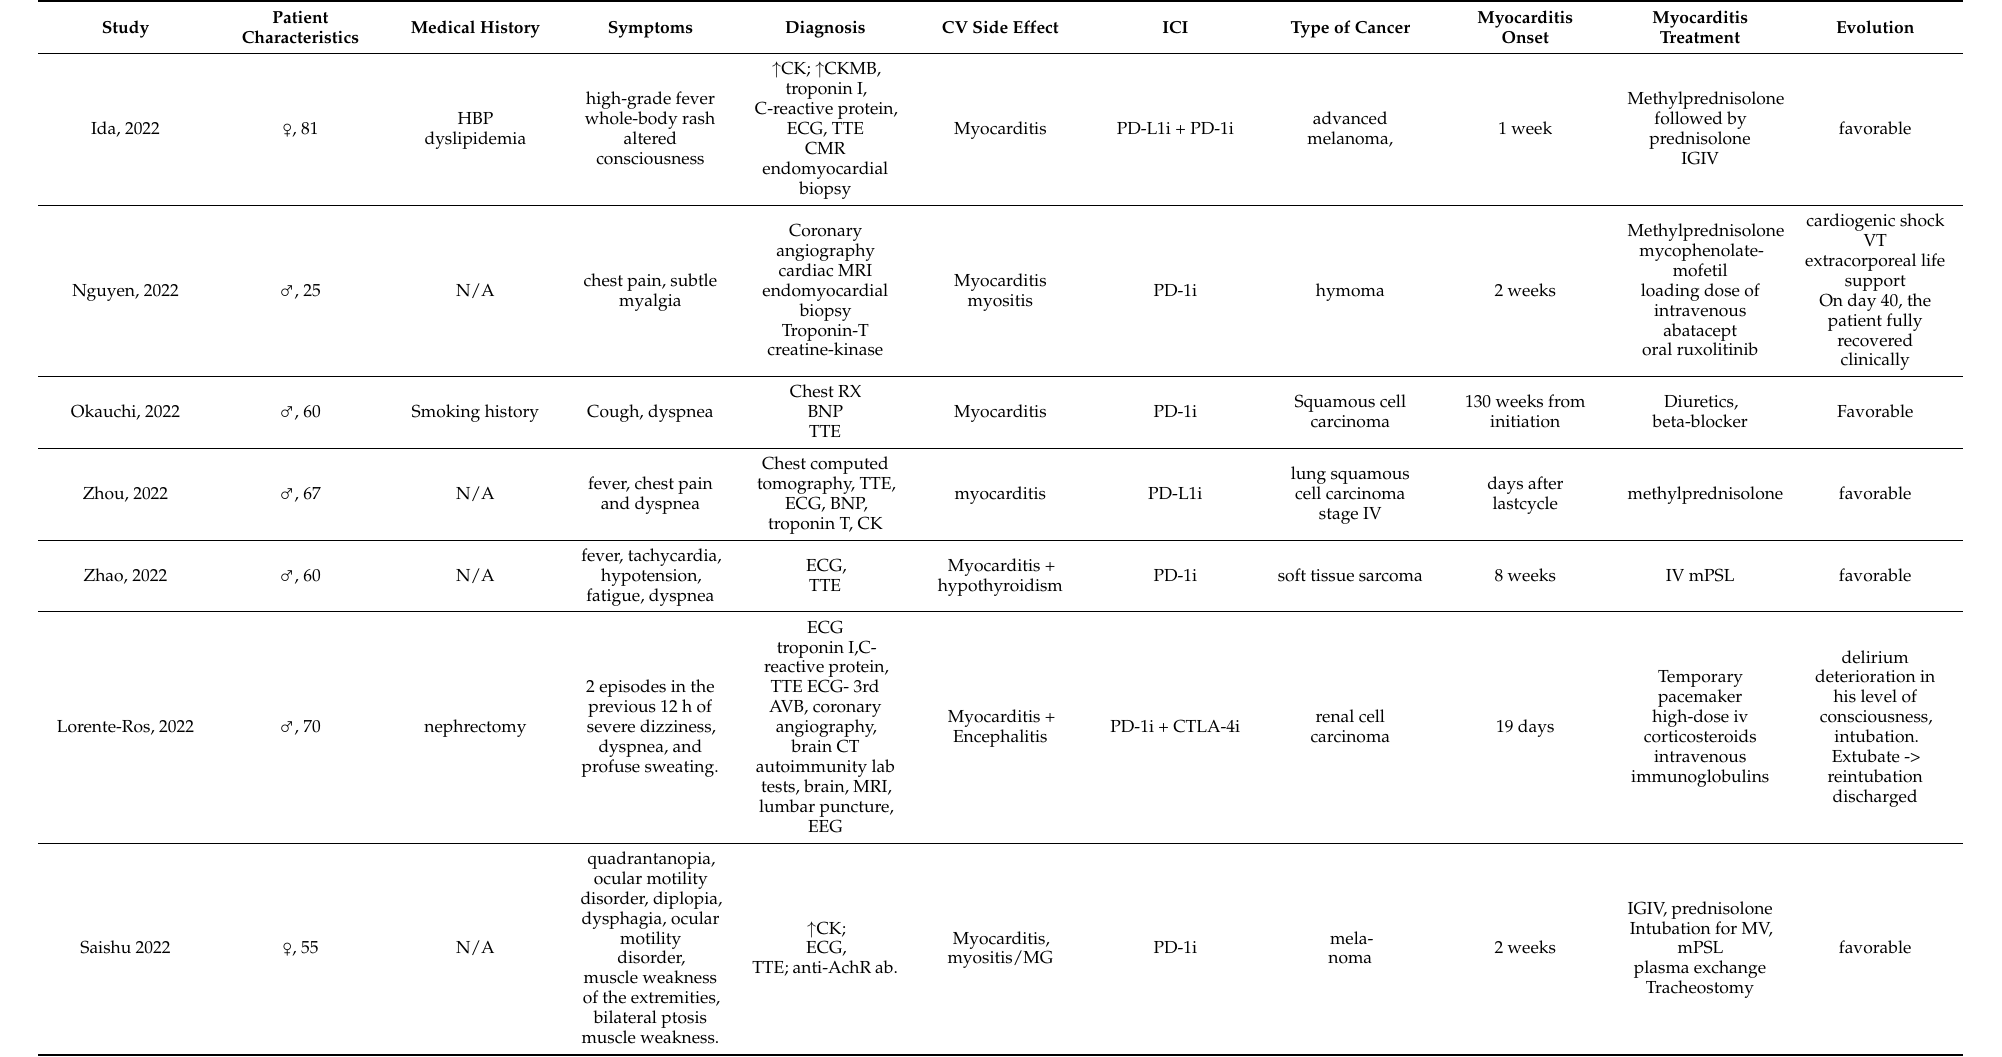
Table 1. Case reports published from 2021–2022—ICI-related